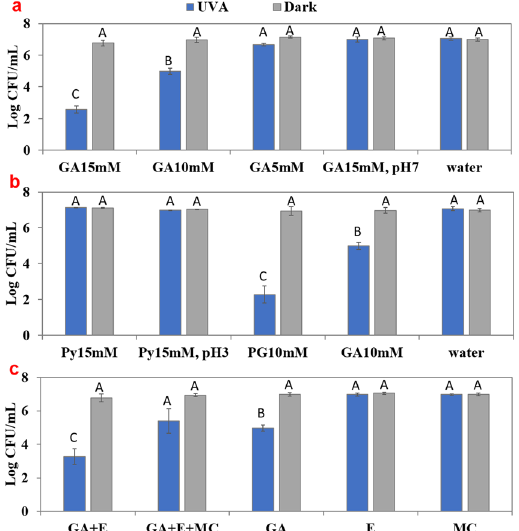
Figure 1. Evaluate the effect of GA concentration, solution pH, derivatives of GA and EDTA on the antimicrobial activity in the absence or presence of UV-A light. Logarithmic reduction of E. coli O157:H7 in the absence or presence of UV-A light and presence of ( a ) GA (0, 5, 10, 15 mM) and GA (15 mM) in phosphate buffer pH 7.4, ( b ) Pyrogallol (Py, 15 mM) or Propyl Gallate (PG, 10 mM), and ( c ) 15 mM GA + EDTA (E, 1 mM) with or without addition of 2 mM Mg 2 + and 2 mM Ca 2 + (MC). Mean ± SD. Means sharing the same letter are non-significant at P < 0.05 according to Tukey’s HSD